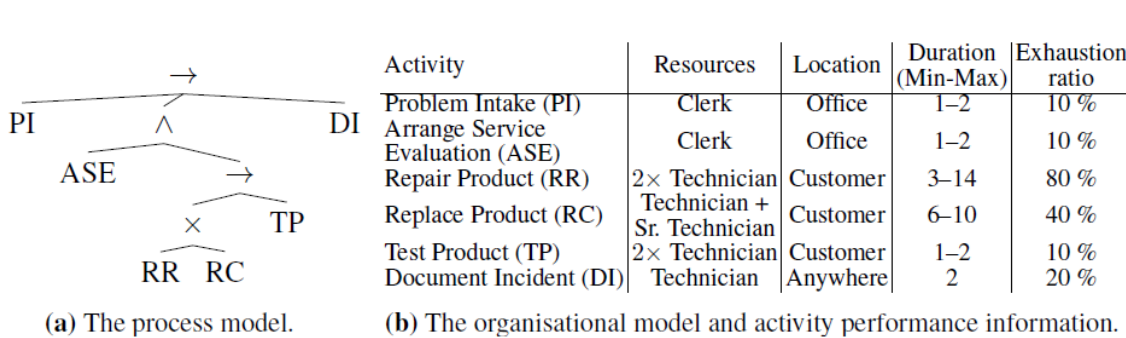
Figure 4. The process knowledge for a simple hardware maintenance process, as used in our simulation is assumed that the role of Senior Technician may also perform any job requiring a Technician .